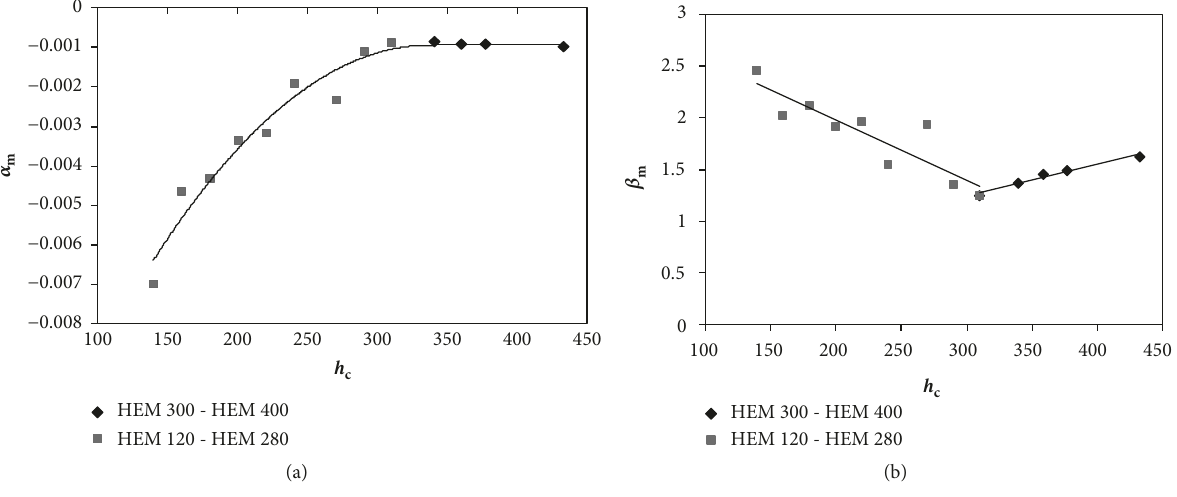
Figure 10: 𝛼 m (a) and the intercept 𝛽 m (b) of equation (5) and equation (6).